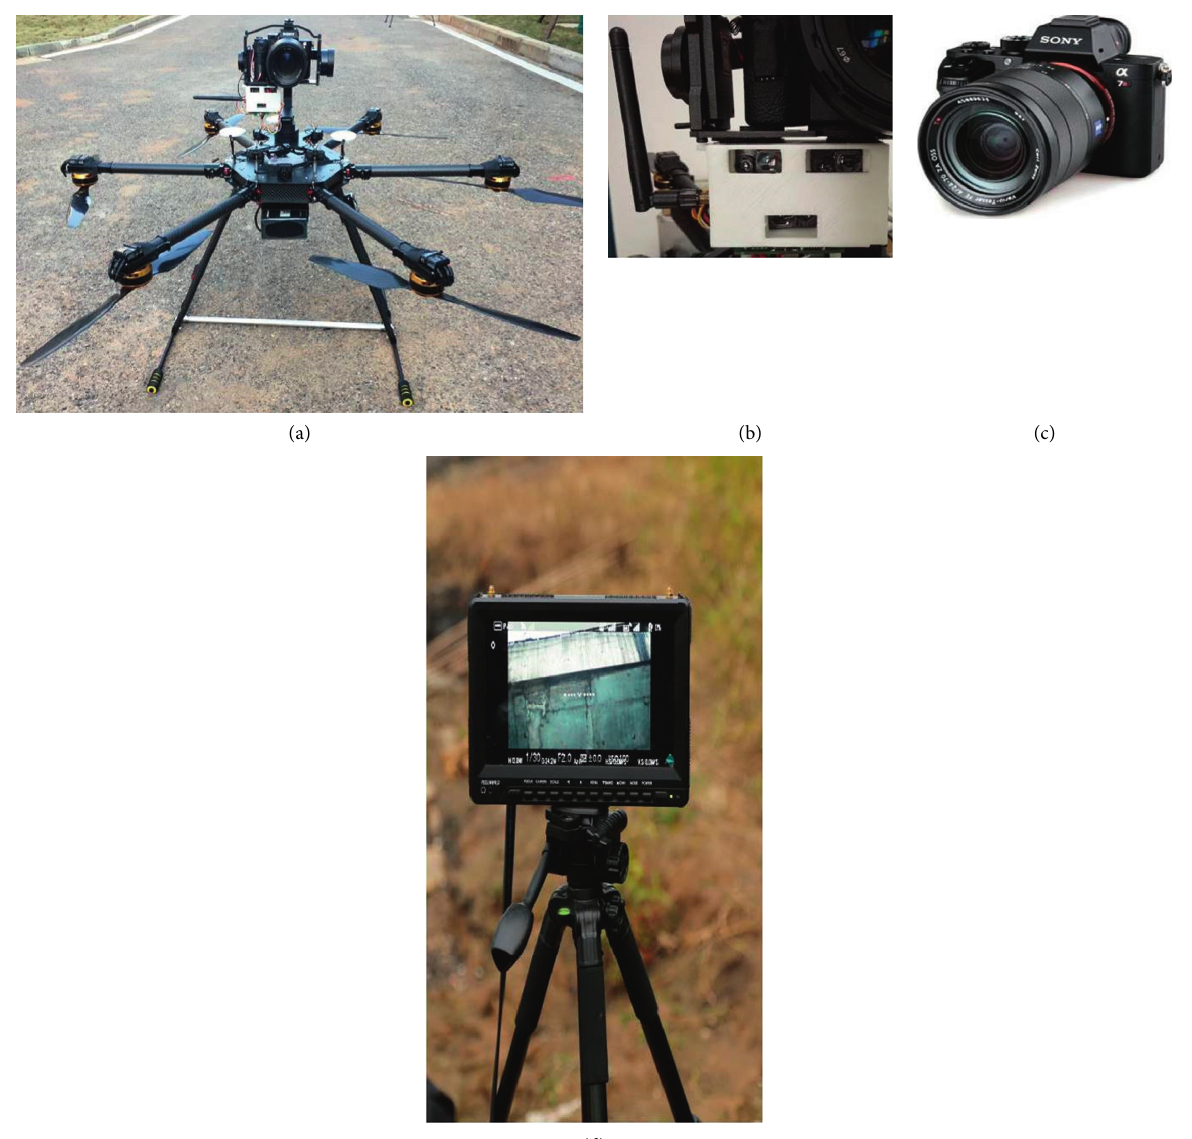
Figure 4: EHM-6V UAV system, (a) UAV system, (b) three-point laser rangefinder, (c) Sony ILCE-7RM2 camera, and (d) high-definition transmission